Question: Express in one sentence what the figure is showing.
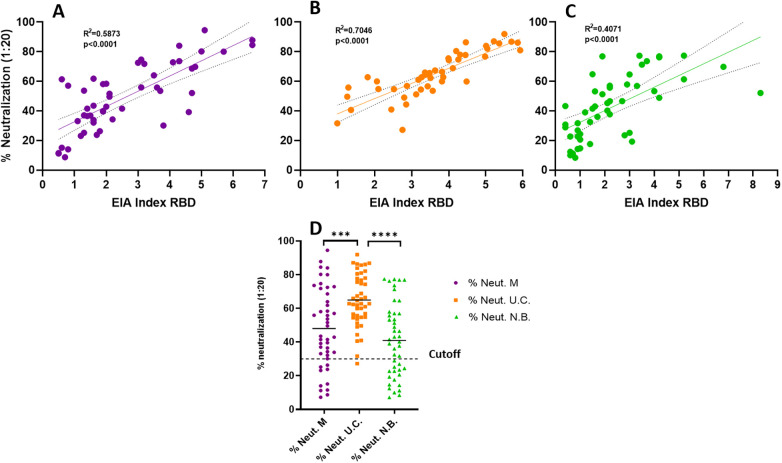
Answer: Correlation analysis between EIA Index RBD and % of neutralization for (5A) mothers, (5B) UC and (5C) NB. Percentage of GM between mothers, UC and NB (5D). (***) Indicates a significance level of P < 0.0005, (****) Indicates a significance level of P < 0.0001 Tukey's ANOVA means comparison test.